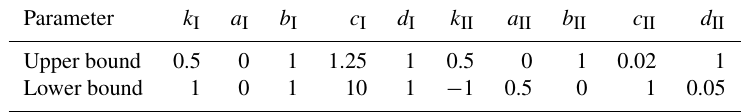
Table 1. Values of the transfer functions used for upper- and lower-bound parametrization in OS2. Parameter k I a I b I Upper bound 0.5 Lower